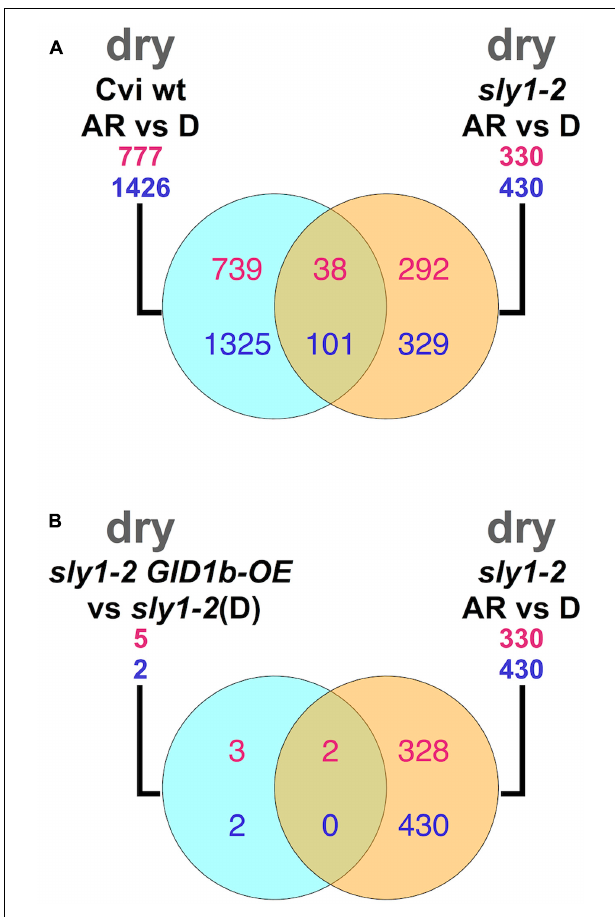
FIGURE 4 | Comparisons between dry transcriptome datasets. (A) The overlap between sly1-2 and Cvi dry seed after-ripening regulated datasets. Cvi dataset is from Finch-Savage et al. (2007). (B) The overlap between dry seed GID1b-OE -regulated and after-ripening regulated mRNAs.